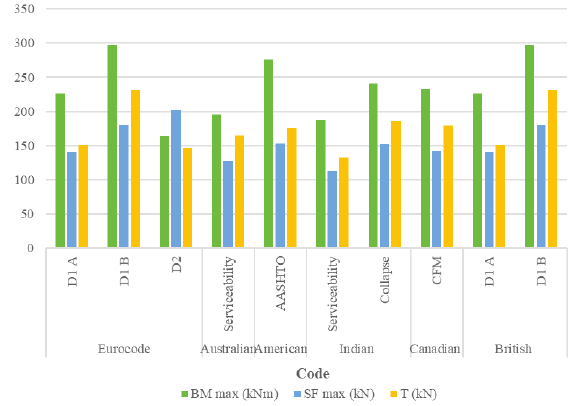
, S.F and T. max max